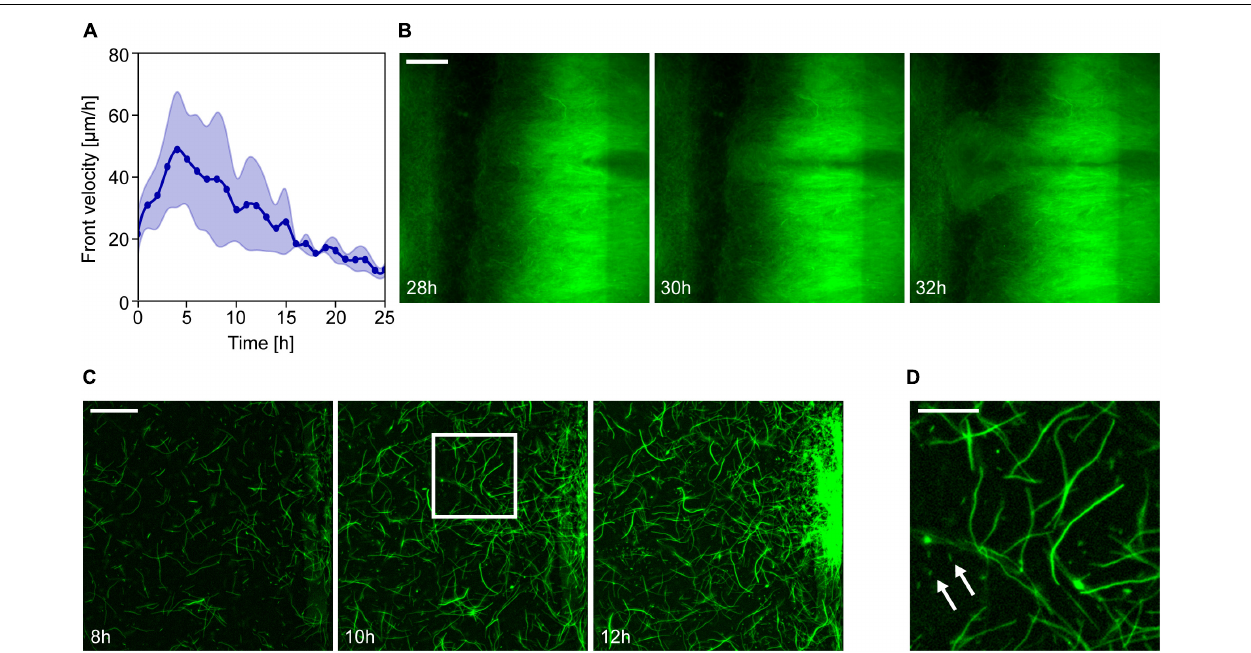
FIGURE 2 | Formation and expansion of resistant Escherichia coli populations in ciprofloxacin gradients. (A) Changes in the velocity of the propagating front in time. The graph represents the average of the front velocity in experiments with 3 × MIC gradient (thick line, n = 4) together with the standard deviation. Zero time marks the moment the intense expansion of the population starts. (B) Fluorescence images showing the emergence of a less bright but fast-growing subpopulation at a specific location on the low ciprofloxacin side of the channel (scale bar is 200 µ m). (C) Emergence and growth of a resistant subpopulation on the low antibiotic concentration side of the observation channel. Series of fluorescence images taken at different time points of the experiment (scale bar is 50 µ m). (D) Zoom-in of the image taken at 10 h to show E. coli cells with different morphologies (scale bar is 20 µ m). Arrows indicate some normal size rod-shaped cells among filamentous